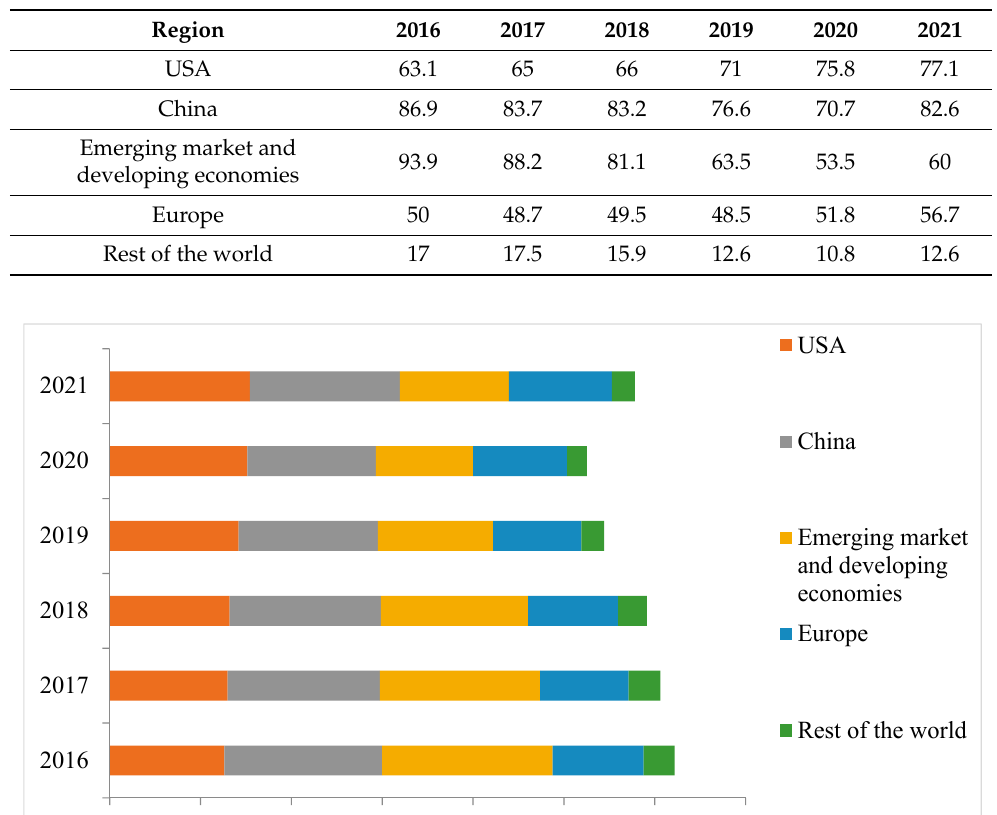
Figure 9. Investment spending in electricity networks by region.